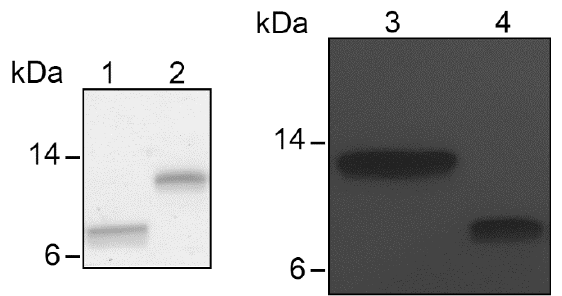
Figure 1. Purified CCL5 5p12 5m-C37. Left panel: Coomassie blue-stained SDS-PAGE of CCL5 5p12 5m (lane 1) and CCL5 5p12 5m-C37 (lane 2) purified from recombinant E. coli expression. CCL5 5p12 5m and CCL5 5p12 5m-C37 have an expected molecular mass of 7.8 and 13 kDa, respectively. Right panel: Western blot of purified CCL5 5p12 5m-C37 (lane 3) and CCL5 5p12 5m (lane 4).